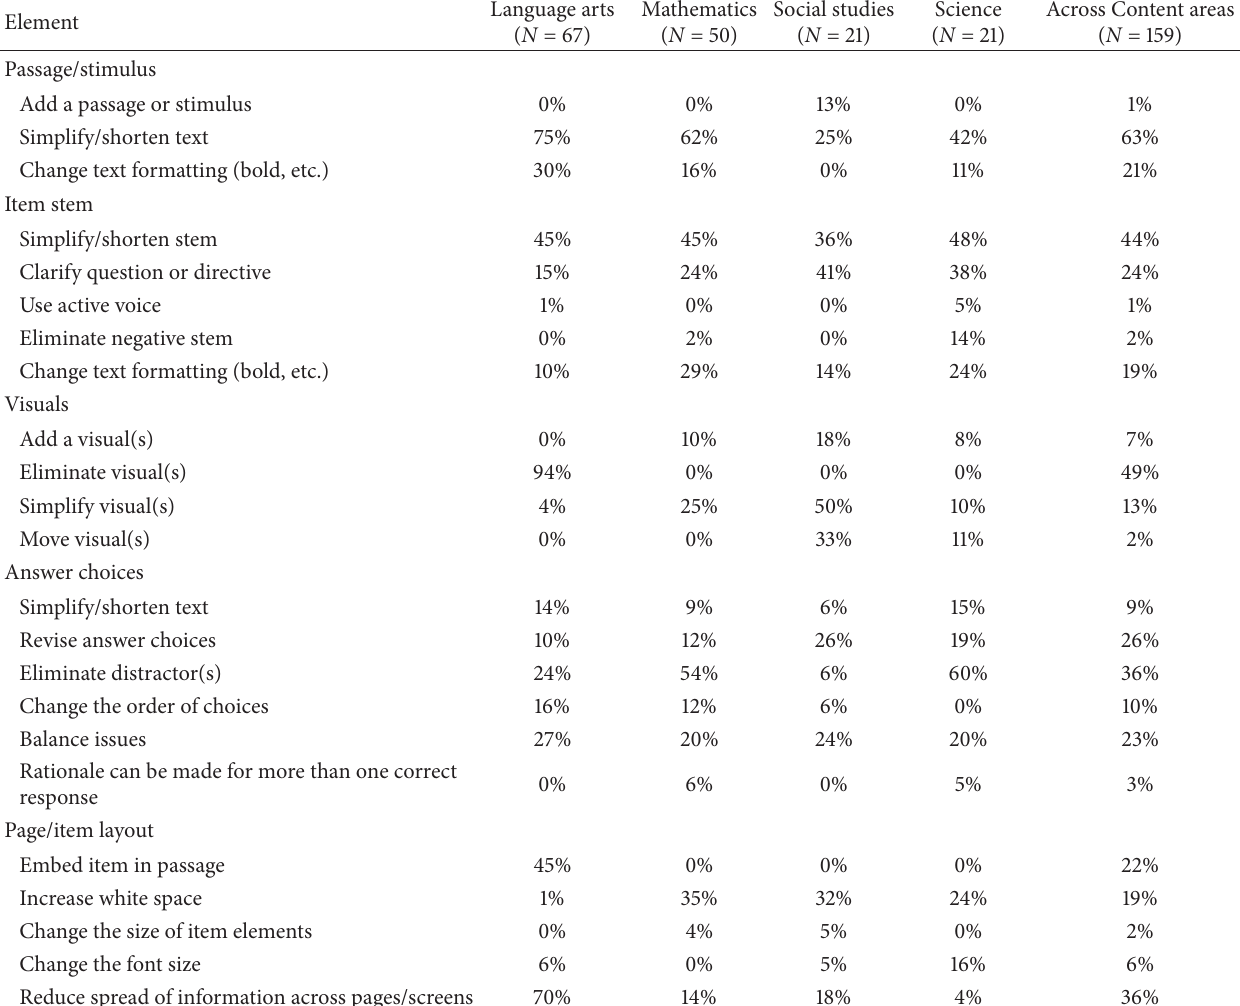
Table 3: Suggested modifications for items from State A, percentages by content area.